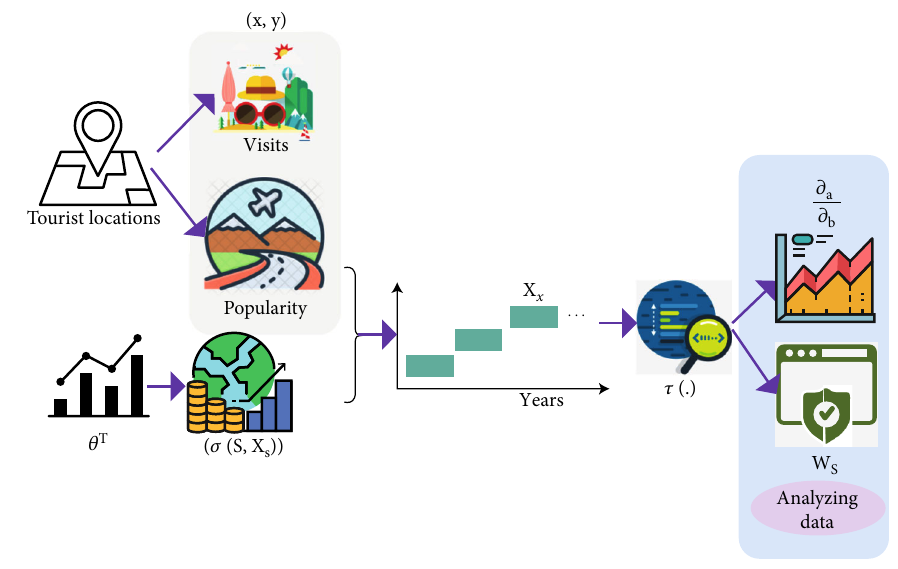
Figure 2: Data analysis